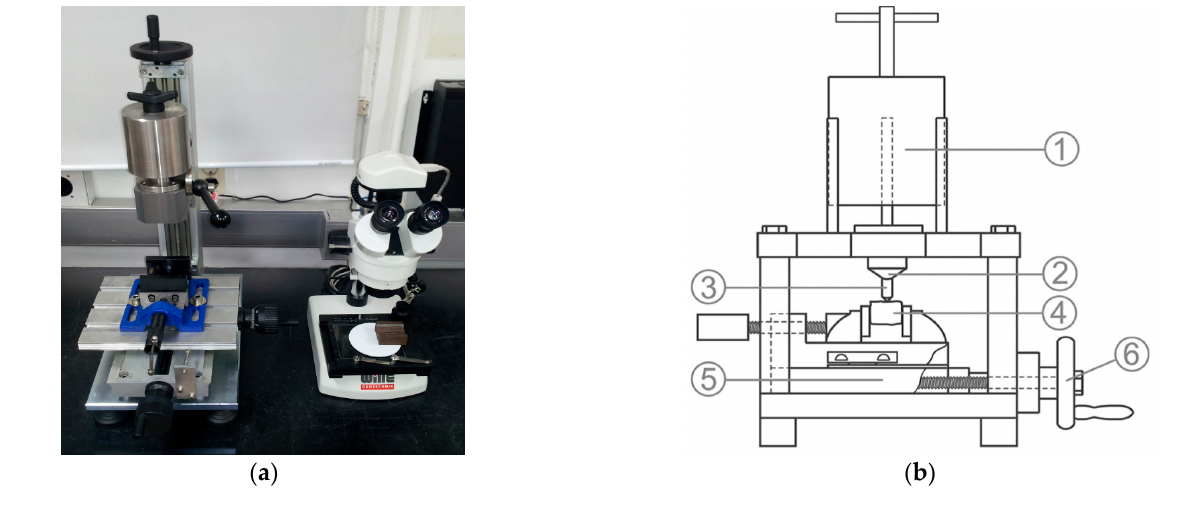
Figure 2. The Cerchar abrasivity test system used in this study: ( a ) photo; ( b ) schematic drawing (1 is weight, 2 is pin guide, 3 is steel pin, 4 is specimen, 5 is vice sled, 6 is hand crank) (after [35]). Table 4. Cerchar abrasivity index (CAI) values and mechanical properties of Korean rock types.